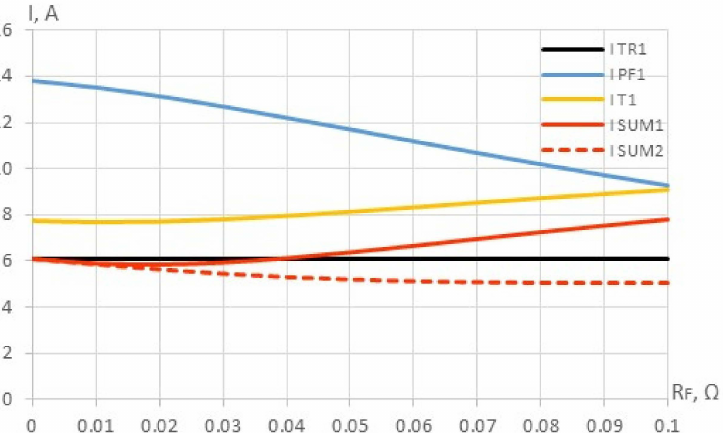
Figure 8. The dependences of the 5th harmonic currents I TR1 , I T1 , I PF1 , I SUM1 , I SUM2 on the passive filter resistance R F (simulation